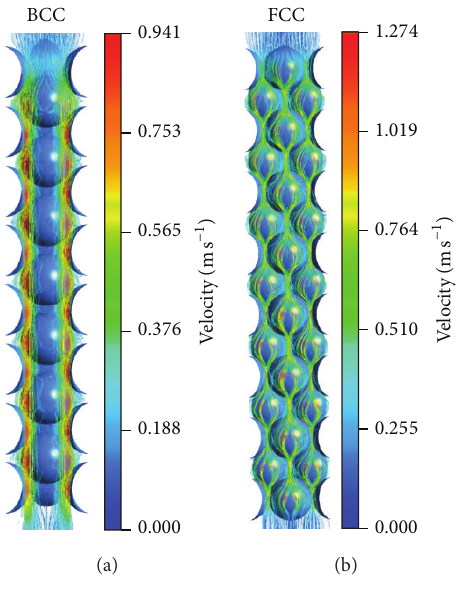
Figure 4: Streamline distributions in BCC and FCC packed cells.